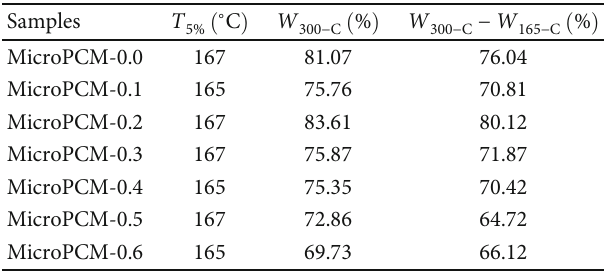
Table 3: Thermo gravimetric results of the micro-phase-change materials improved with various quantities of HO-carbon nanotubes.